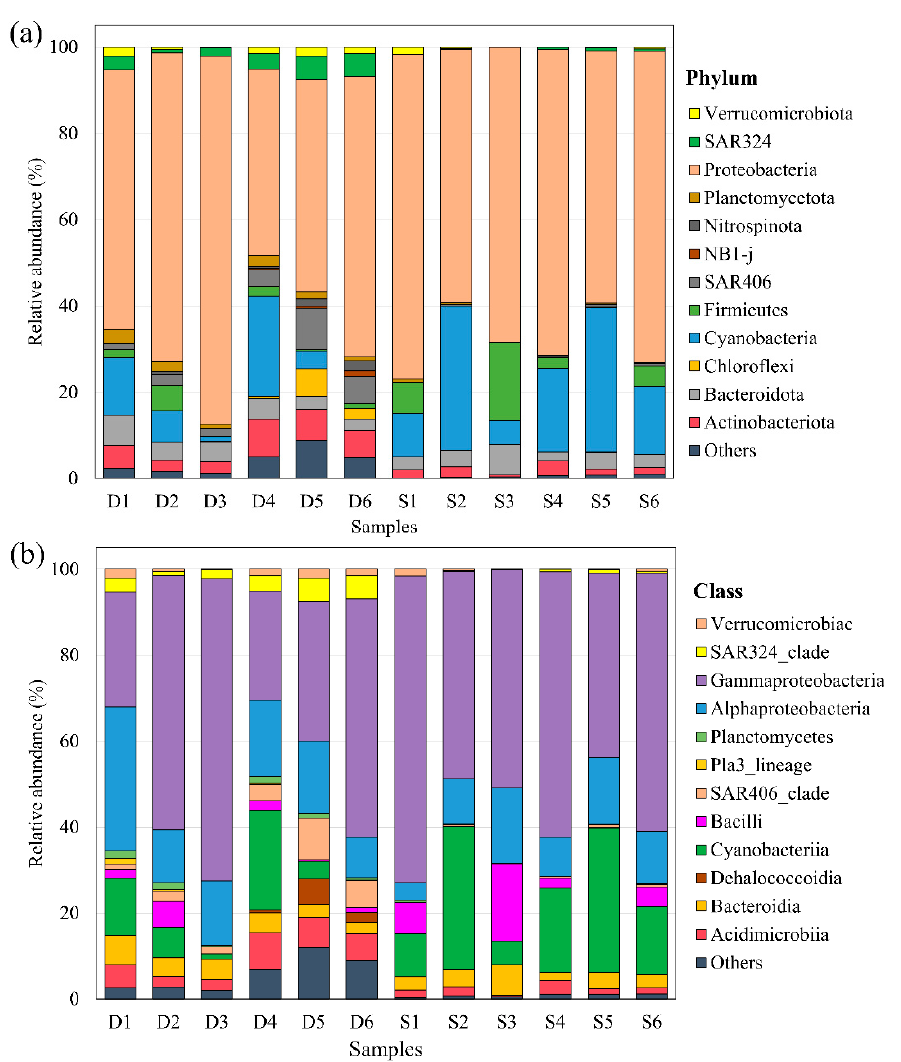
Figure 2. Relative abundance of bacteria at the phylum level ( a ) and class level ( b ). S and D indicate surface water and deep water, respectively. The number following S or D indicates the sampling station.